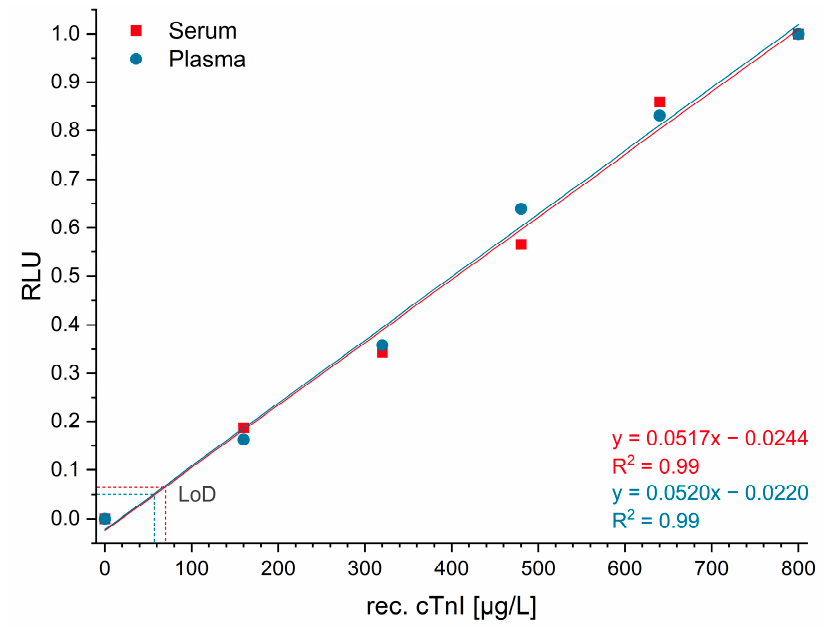
Figure 13. Linearity of the cTnI detection in spiked human serum and plasma. Limits of detection (LoD) of 70 and 60 µg/L for serum and plasma, respectively, have been calculated.